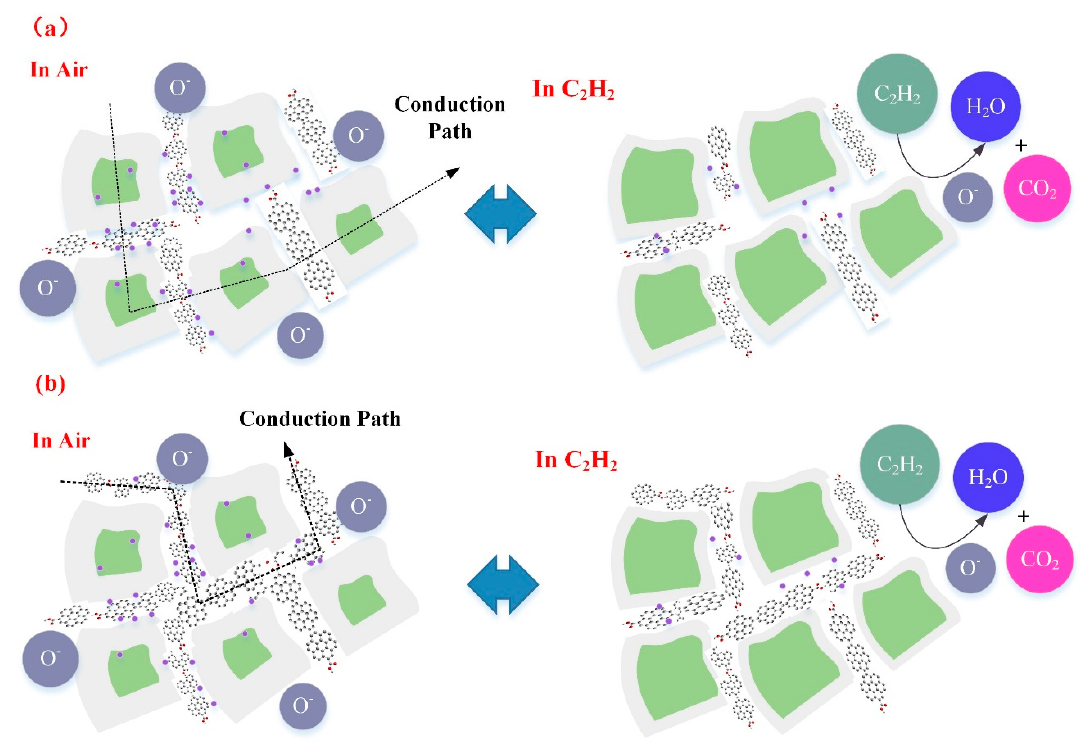
Figure 16. ( a ) Representative physical models for C 2 H 2 gas sensing mechanism of WG1; and, ( b ) Representative physical models for C 2 H 2 gas sensing mechanism of WG2 and WG4.